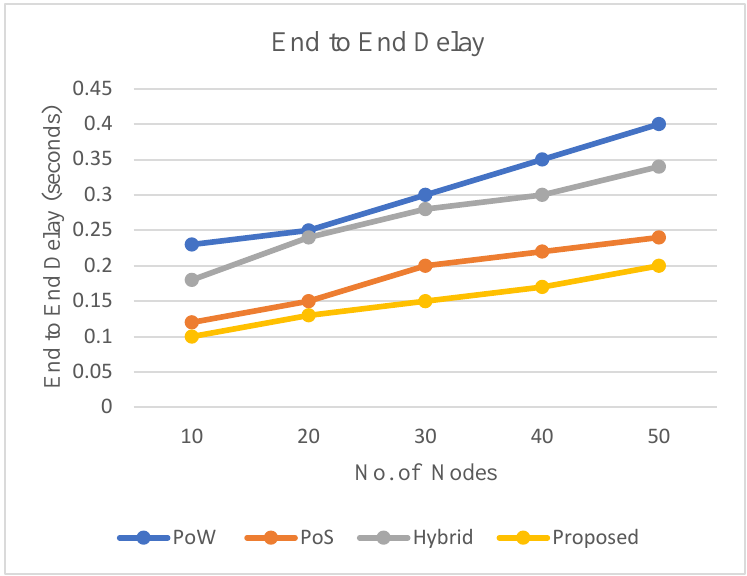
Figure 8. End-to-end delay.